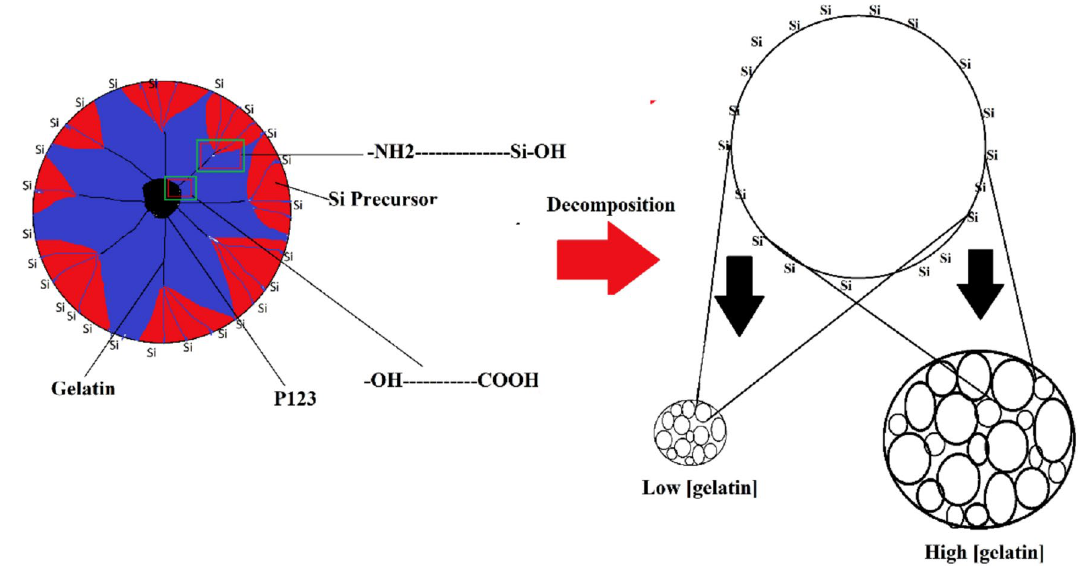
Figure 1. The micellar aggregation from P123-gelatin with Si precursor for NSG